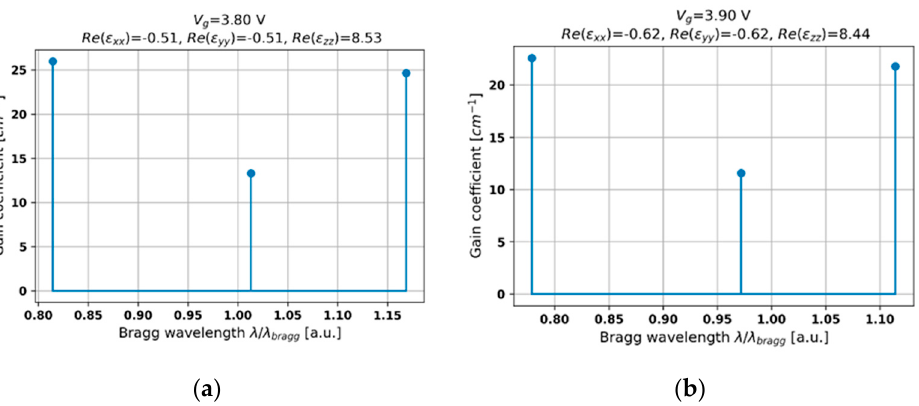
Figure 8. Threshold modal spectra for PHC structures with HMM structures revealing type II hyperbolic dispersion and biased with external voltage V g = 3.8 V ( a ) and 3.9 V ( b ).